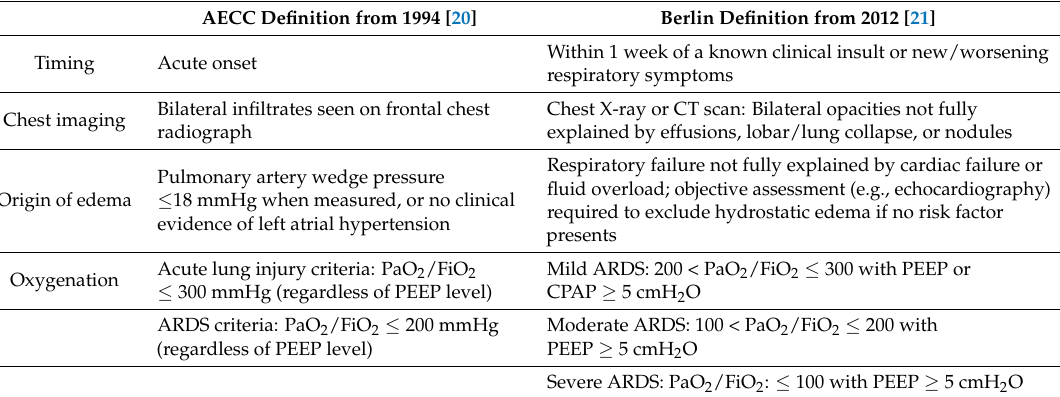
Table 1. The diagnostic criteria of the American-European Consensus Conference (AECC) and Berlin